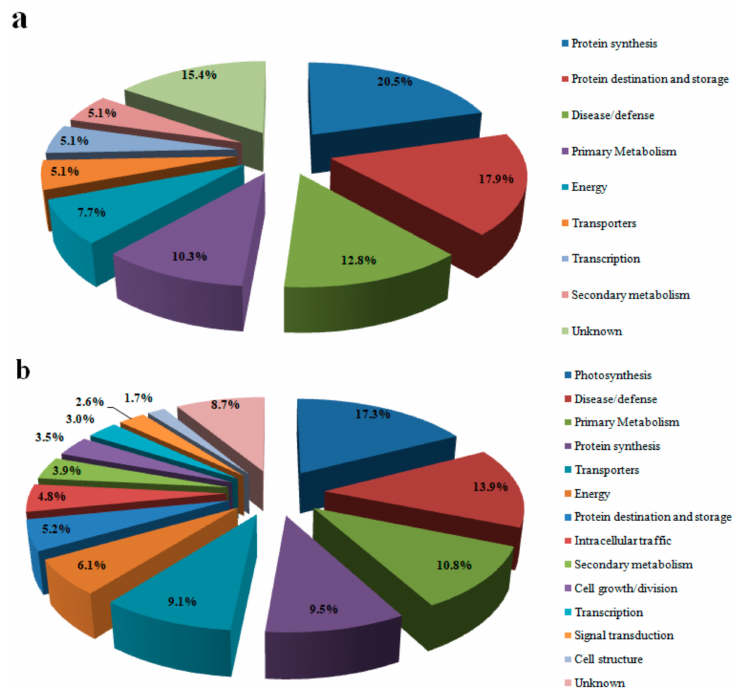
Figure 2. Functional classification of di ff erentially expressed proteins in hemp under Pb stress.